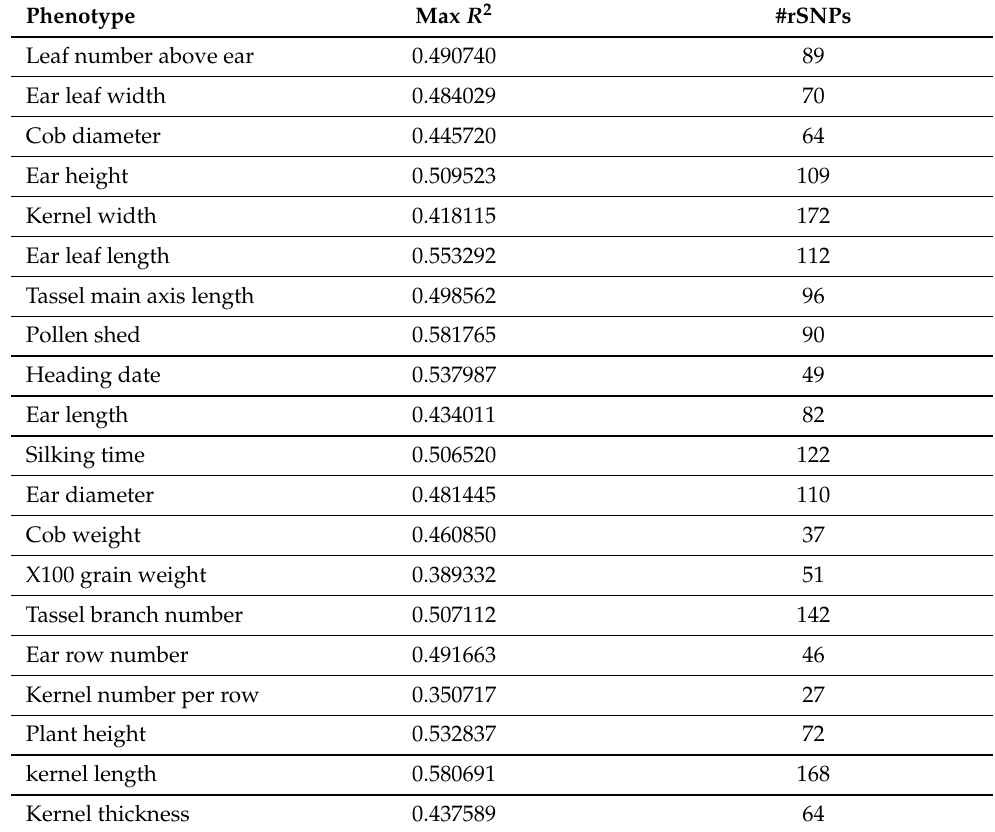
Table 1. Phenotypes and the optimal numbers of their associated rSNPs determined by incremental feature selection (IFS)